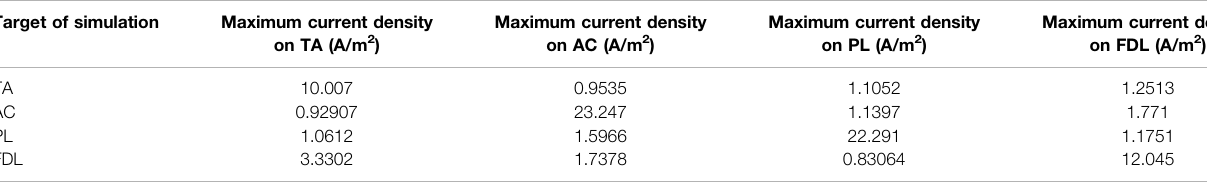
TABLE 2 | Maximum current density distribution on each targeted tendon in each